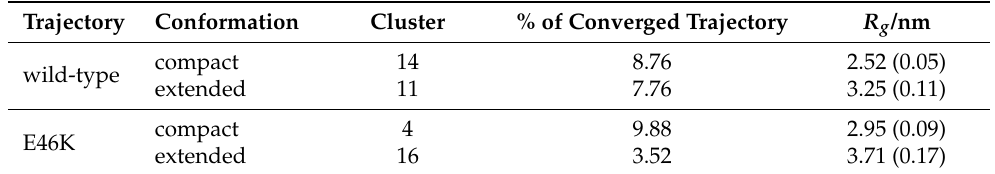
Figure 1. Radius of gyration of wild-type and E46K-mutated AS. Distributions over the converged part of the trajectories ( A ), and over the 20 K-means wild-type ( B ) and E46K mutant ( C ) clusters. The converged t–SNE projections of RMSD used to obtain the K-means clusters of the wild-type (Perplexity = 100) ( D ) and E46K mutant (Perplexity = 350) ( E ). Table 1. Clusters chosen to represent compact and extended conformational structures in trajectories of wild-type AS and E46K